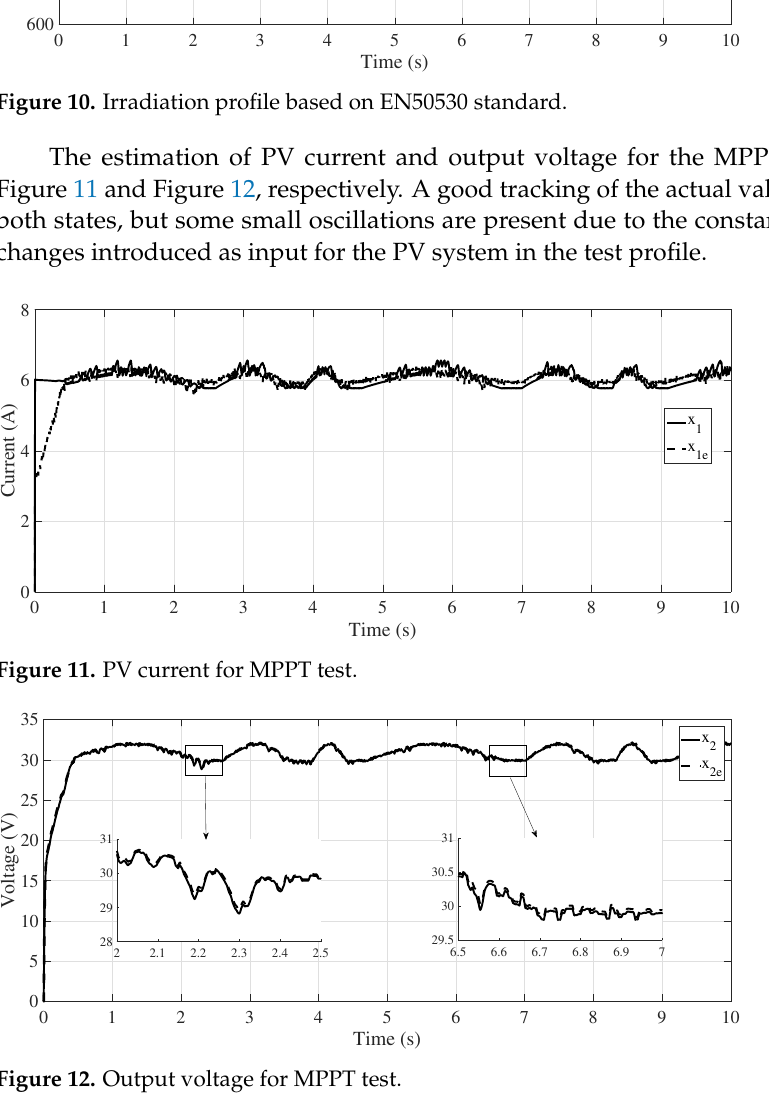
Figure 12. Output voltage for MPPT